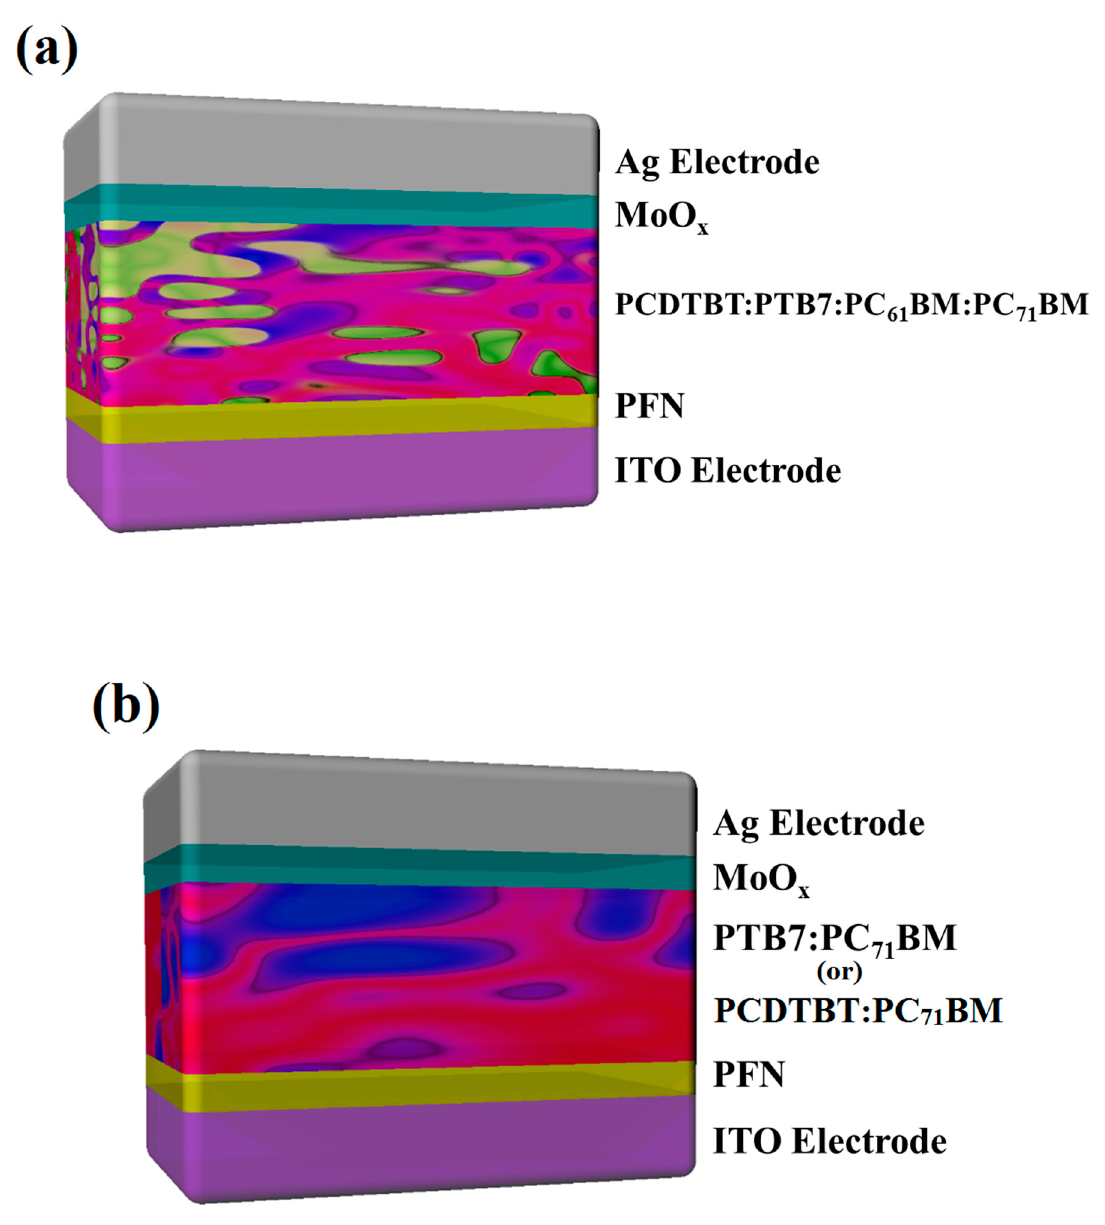
Figure 1. ( a ) Device structure of the quaternary photovoltaic: ITO / PFN / poly[N-9 (cid:48) -hepta-decanyl-2,7- carbazole-alt-5,5-(4 (cid:48) ,7 (cid:48) -di-2-thienyl-2 (cid:48) ,1 (cid:48) ,3 (cid:48) -benzothiadiazole)]:poly[[4,8-bis[(2-ethylhexyl)oxy]benzo[1,2-